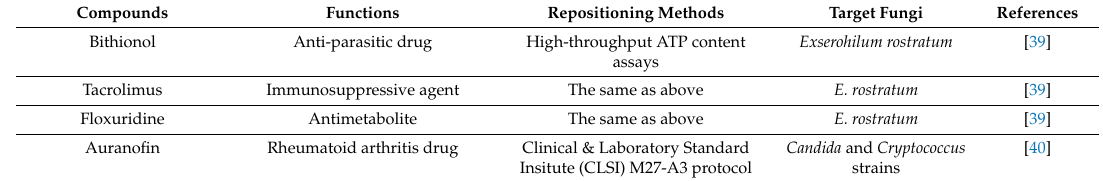
Table 1. Repositioning of non-antifungal drugs to